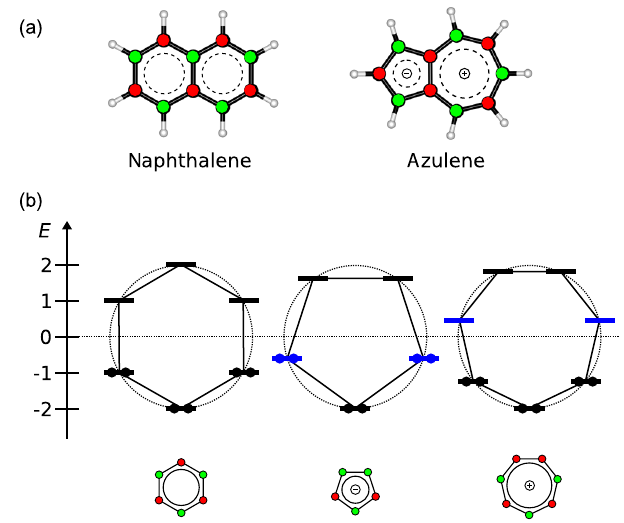
FIG. 11. (a) Alternating labeling of the carbon atoms (red, green), illustrating that the 6-6 system has an alternant and the 5-7 system has a nonalternant π system. The dipole moment of the 5-7 system can also be understood as a consequence of the Hückel 4 n þ 2 rule for aromatic systems [91], which requires transfer of one electron from the heptagon to the pentagon, such that an aromatic sextet (Clar sextet) can be formed [92]. (b) Frost- Musulin diagrams [93] for 6-, 5-, and 7-membered cyclic π systems. The HOMO level of the 5-membered ring and the LUMO level of the 7-membered ring are highlighted in blue. All π -MO energies lie on a circle, which is centered at the Coulomb integral α and has the radius of 2 times the Hückel exchange integral β . The energy scale is in units of x , with x ≡ ð α − ε Þ = β , where ε is the π -MO energy. Only the 6-membered ring is alternant and fulfills the Coulson-Rushbrooke theorem. In the 5- membered system, the HOMO is lifted, and in the 7-membered system, the LUMO is lowered. The hexagon has a neutral closed- shell state, whereas the pentagon and the heptagon form a closed- shell anion and cation,